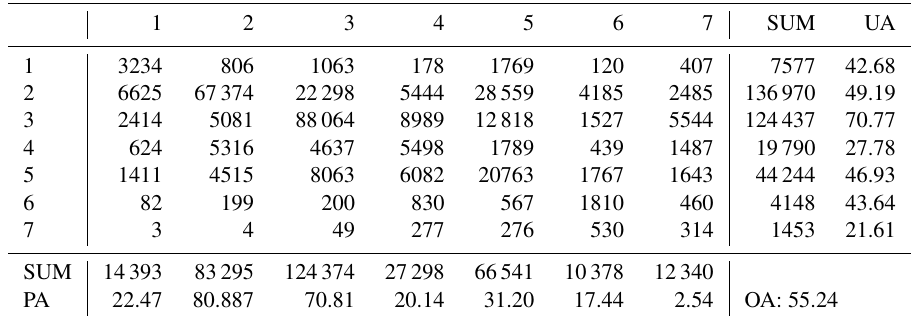
Table B2. Confusion matrix for LANDMATE PFT group 0.2 – the dominant LULC type occupies a minimum of 20% of a LANDMATE PFT grid cell.